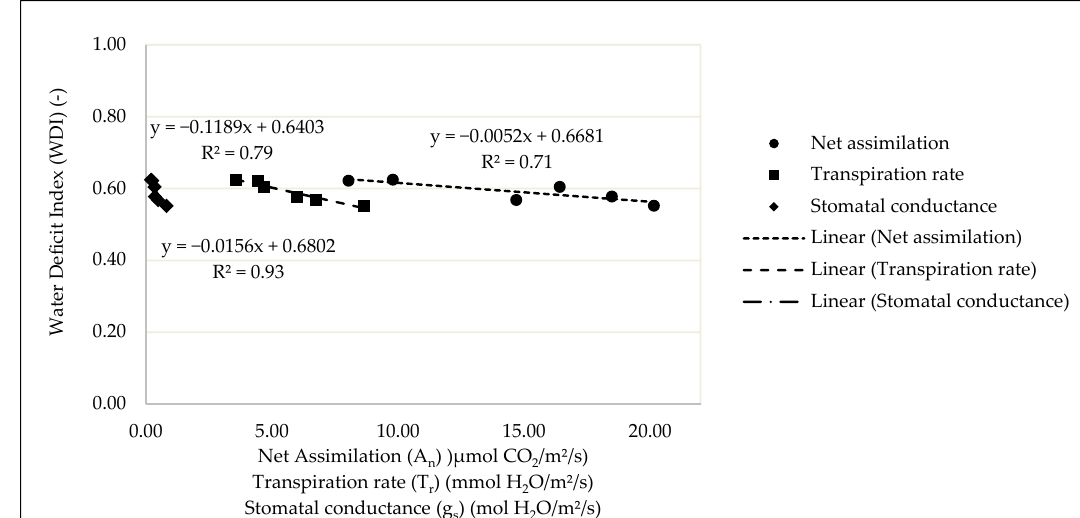
Figure 2. The parameters of linear regression (R²—correlation coefficient) between leaf gas exchange variables (g s —stomatal conductance, A n —net assimilation, and T r —transpiration rate) and the thermal index (WDI—Water Deficit Index)).